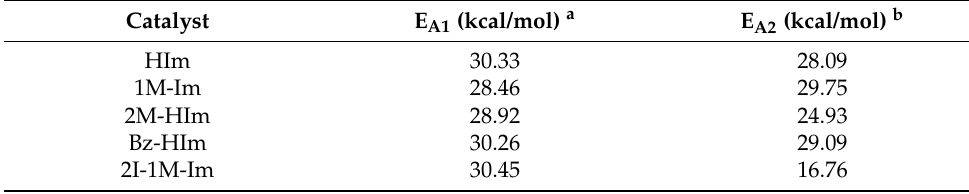
Table 2. Activation energies for step 1 (E A1 ) and step 2 (E A2 ) of the reaction pathway. Catalyst E A1 (kcal/mol) a E A2 (kcal/mol) b HIm 30.33 28.09 1M-Im 28.46 29.75 2M-HIm 28.92 24.93 Bz-HIm 30.26 29.09